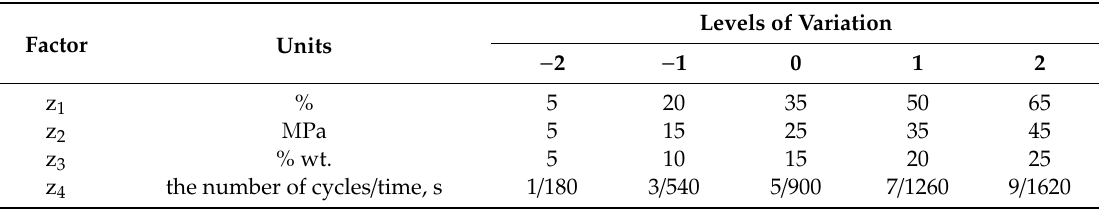
Table 3. Conditions of the